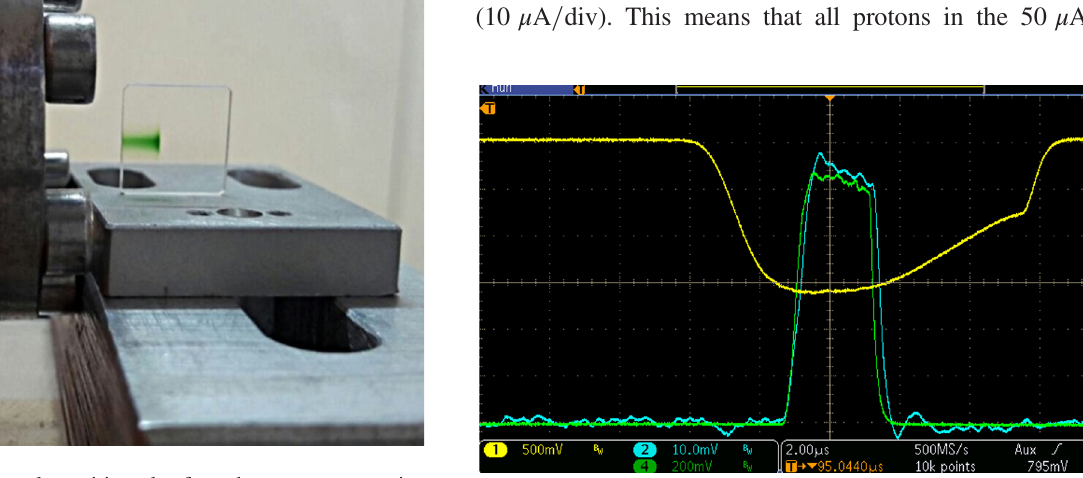
FIG. 16. Oscilloscope signals: Injected current in SCDTL-1 read by ACCT1 (yellow trace, 500 mV = div), SCDTL-4 output current read by ACCT2 (blue trace, 10 mV = div), and FC (green trace, 200 mV = div). The horizontal scale is 2 μ s =